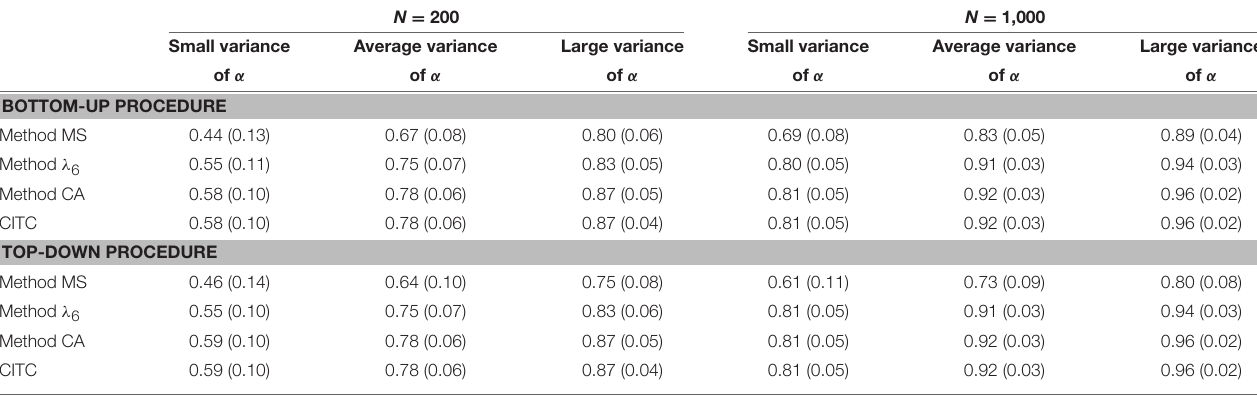
TABLE 4 | Mean Kendall’s τ for 1,000 replications between the ordering based on the population test-score reliability and the ordering produced by the three item-score reliability methods and the corrected item-total correlation (CITC), for the bottom-up and the top-down procedure in the six different conditions. N = 200 N = 1,000 Small variance Average variance Large variance Small variance Average variance Large variance of α of α of α of α of α of